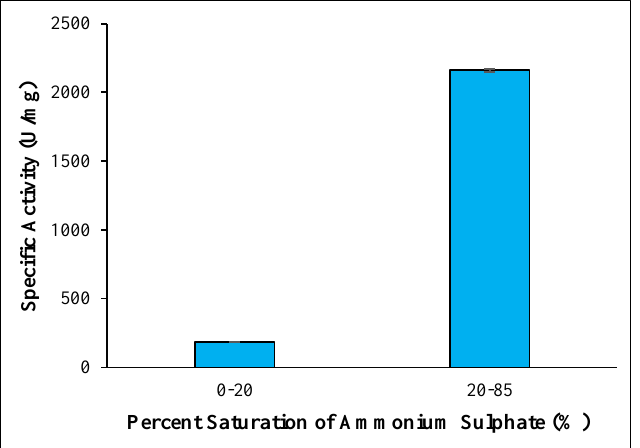
Figure 2. The relationship between (0-20)% and (20-85)% saturation of ammonium sulfate on the enzyme specific activity The enzyme fraction (20-85)% was purified by dialysis overnight using 0.01 M phosphate buffer pH 6.5. After dialysis, the enzyme revealed significant growth in its purity than the crude enzyme which show by the higher of its specific activity. The dialyzed enzyme had specific activity of 8237.09 U/mg. Table 1 summarizes the outcome of this partial purification step. This result shows a 14.5 increase in enzyme purity compared to the crude variant. Furthermore, these characteristics were supported by the relative decline in enzyme yield (%) which implied that the enzyme was free from impurities, especially the salt ions and other proteins. As a comparison in a previous literature, the specific activity of the dialyzed A. fumigatus α-amylase was 4514.67 U/mg [20]. Hence, this present study was successfully improved